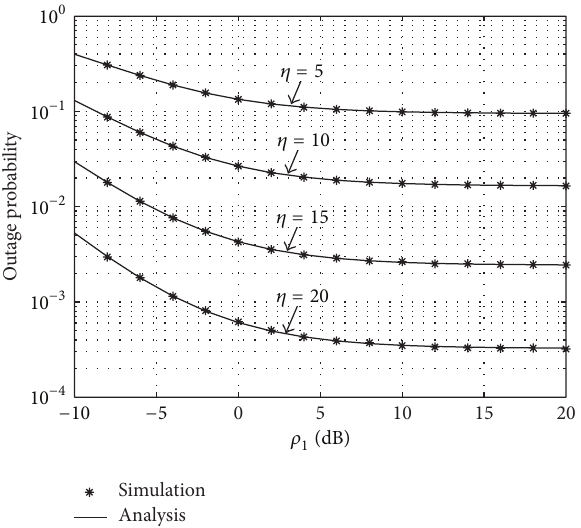
Figure 2: Outage probability of the AF relaying system versus SNR = 0 dB). ( 𝛾 th